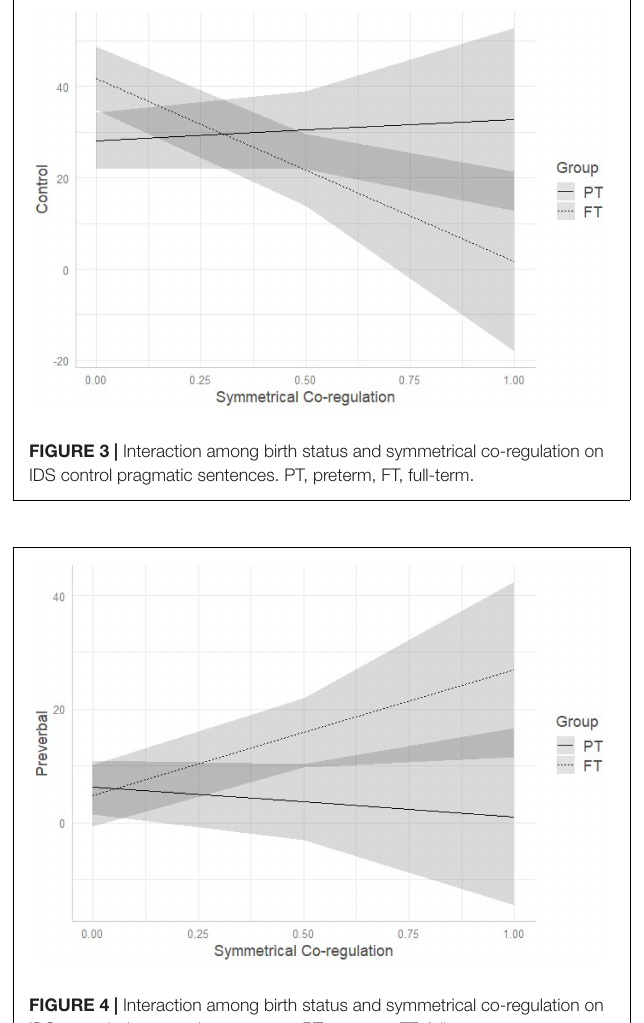
FIGURE 4 | Interaction among birth status and symmetrical co-regulation on IDS preverbal pragmatic sentences. PT, preterm, FT, full-term.